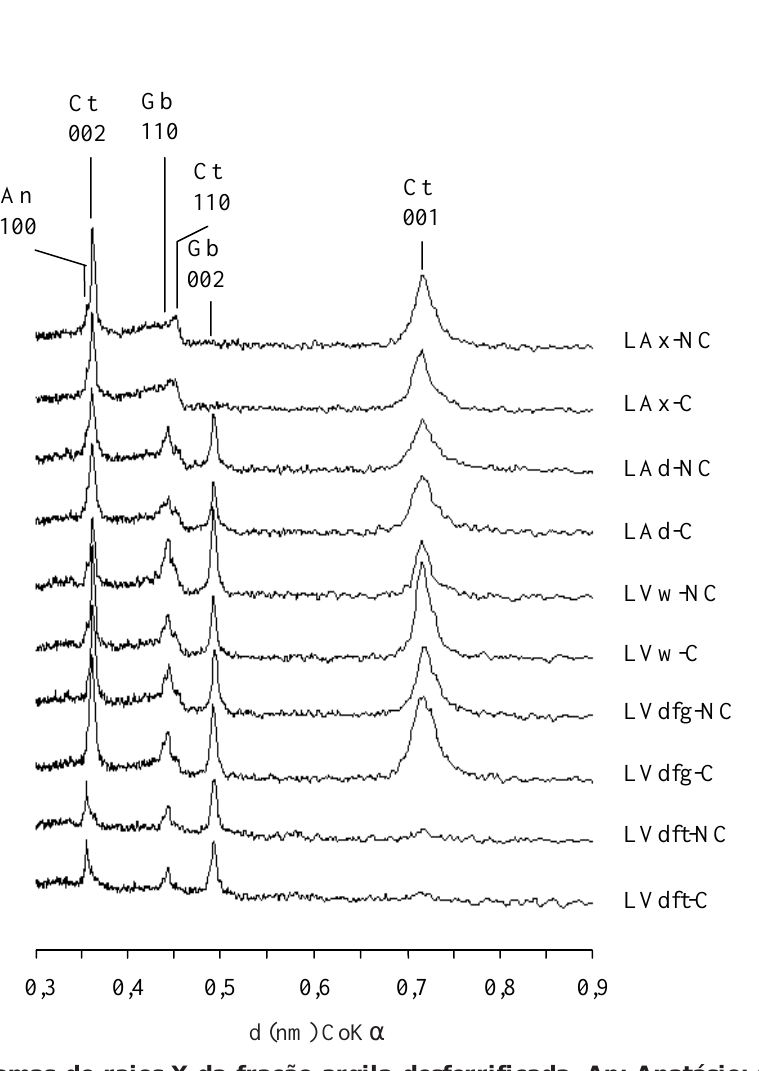
Figura 1. Difratogramas de raios-X da fração argila desferrificada. An: Anatásio; Ct: Caulinita; Gb: